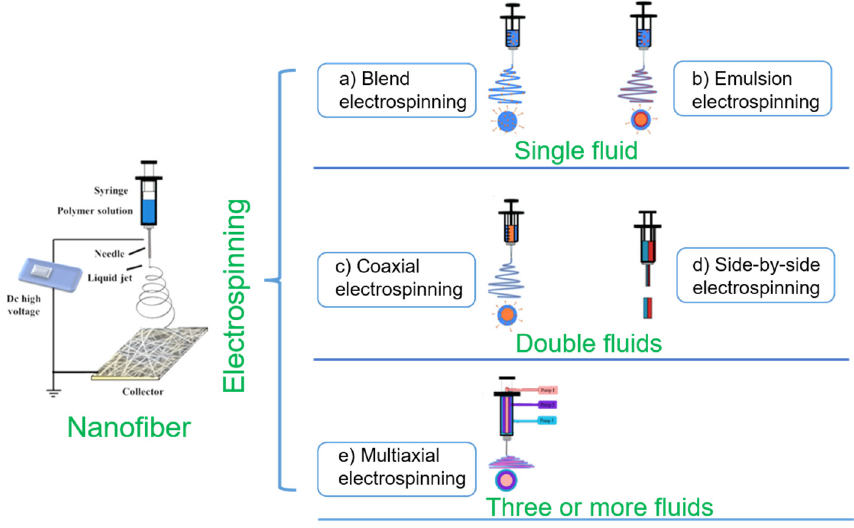
Figure 3. Process classification of electrospinning technology (adapted from [72], with permission from MDPI, 2021). from MDPI,